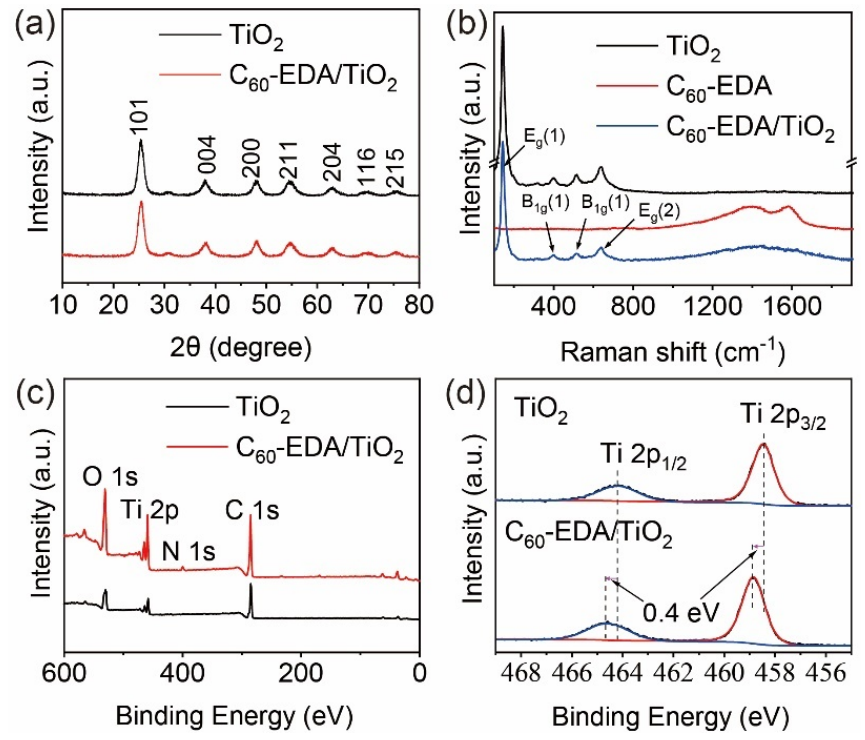
Figure 2. ( a ) XRD, ( b ) Raman, ( c ) full XPS, and ( d ) Ti 2p high − resolution spectra of pristine TiO 2 and C 60 ‐ EDA/TiO 2